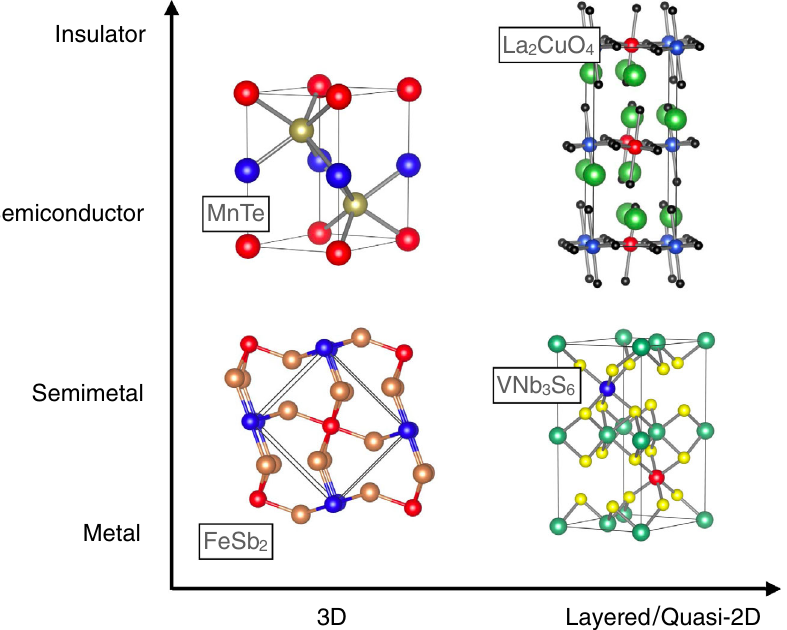
FIG. 5. (a) Spin-polarized relativistic Fermi surface highlight- ing the presence of the approximate spin symmetry ½ C 2 jj C 4 omitted by the magnetic group. (b) Relativistic momentum- resolved Berry curvature hotspots originating from the avoided ¼ 0 lines, whose position in the mo- crossings along the k x;y mentum space is determined by the spin symmetries in the absence of the relativistic spin-orbit coupling. (c) Fermi-surface- resolved Berry curvature of the FeSb 2 altermagnet illustrates pronounced contributions to Berry curvature from the quasinodal ¼ 0 , k ¼ 0 . (d) Brillouin zone notation. This figure is surface k x y adapted from Refs. [5,7,16].